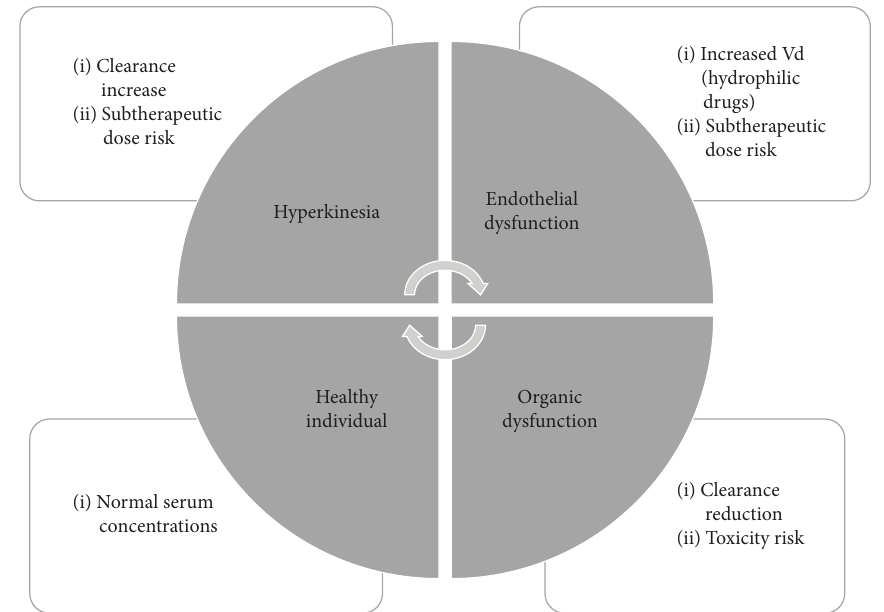
Figure 5: Clinical status of the patient and its infuence on the pharmacokinetics of antimicrobials. Vd: volume of distribution. Modifed from Freitas et al.